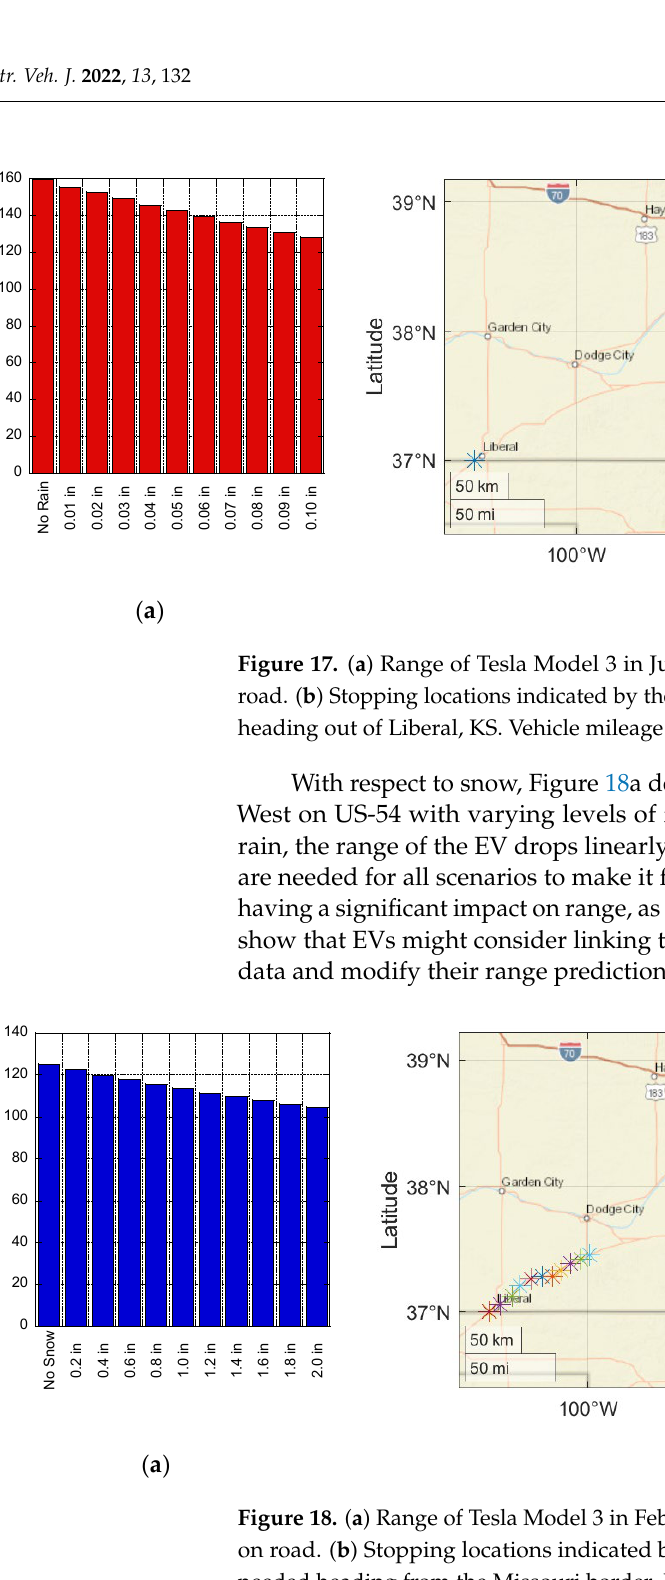
Figure 18. ( a ) Range of Tesla Model 3 in February 2020 heading West on US-54 as a function of snow on road. ( b ) Stopping locations indicated by the symbols * based on snow level with sooner stops needed heading from the Missouri border. Vehicle mileage = 1000 miles, HVAC system on.